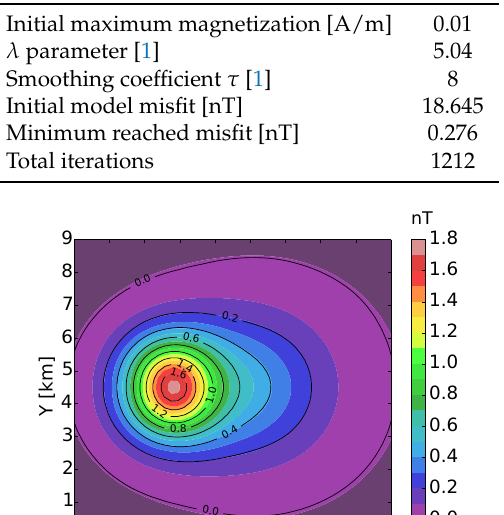
Table 6. Configuration of the magnetic inversion parameters for the S model. Initial maximum magnetization [A/m] 0.01